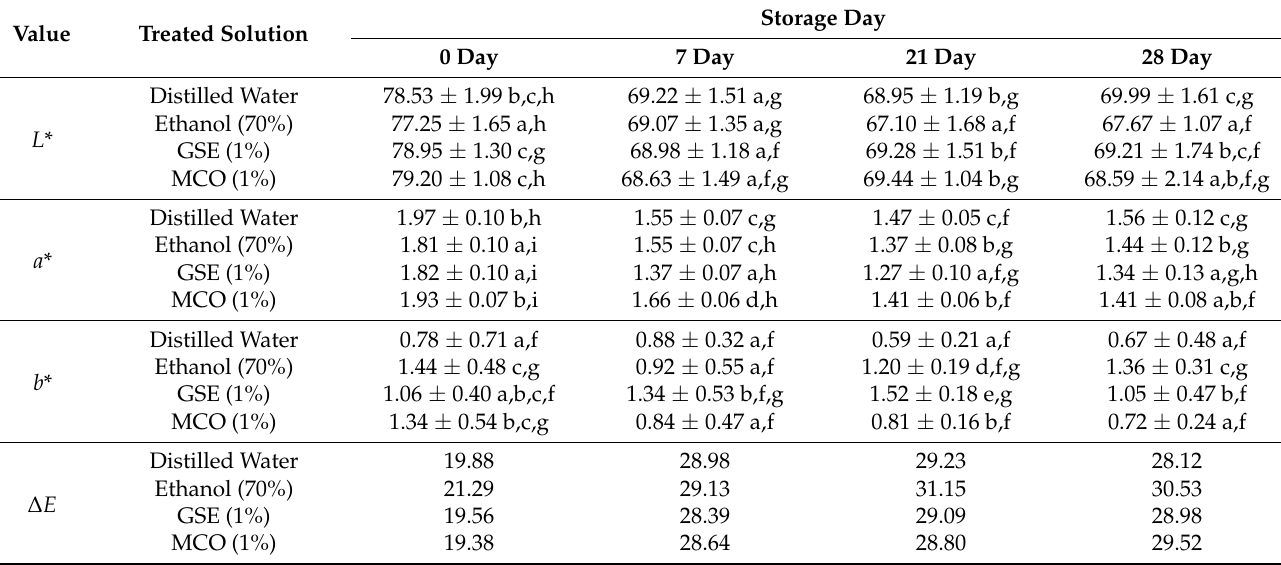
Table 2. Color value of rice cake during storage: L *, lightness; a *, redness; b *, yellowness; ∆ E , total color difference values.